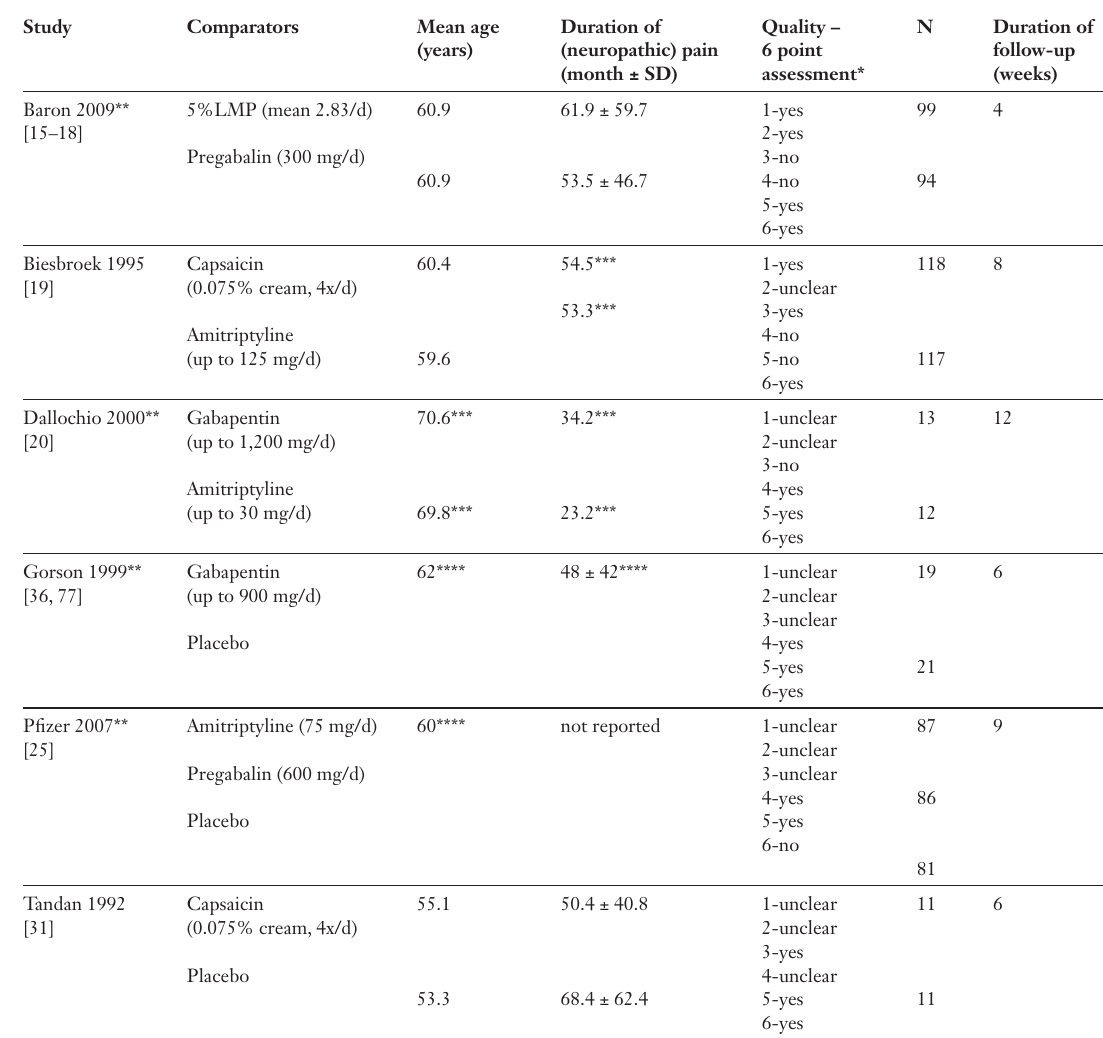
List of studies included in the network meta-